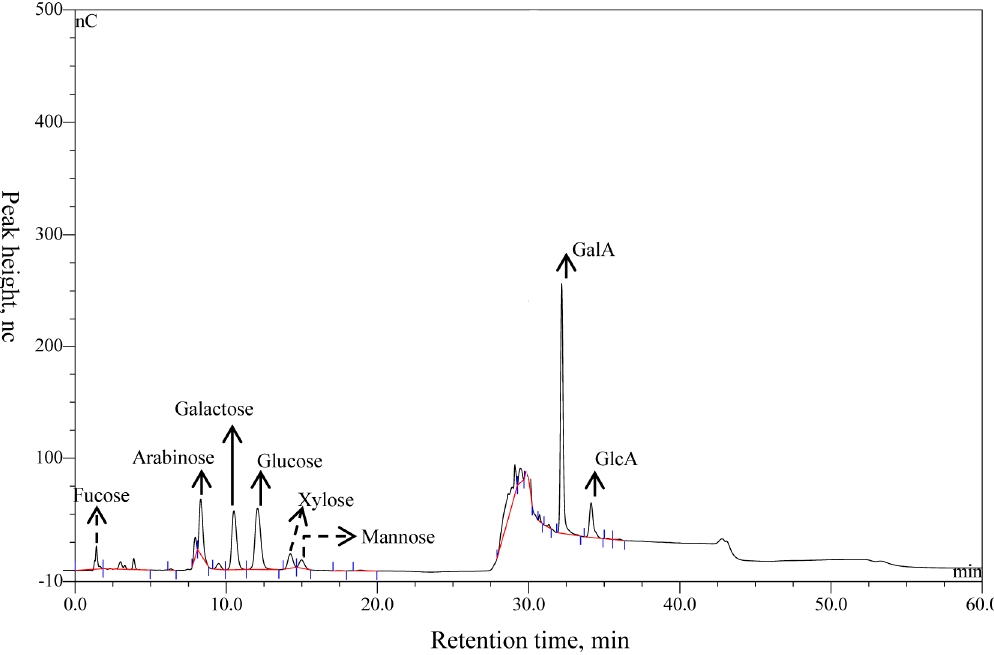
Figure 3. The ion chromatogram of APS. Table 1. The chemical components of polysaccharides fractionated from alfalfa 1 .